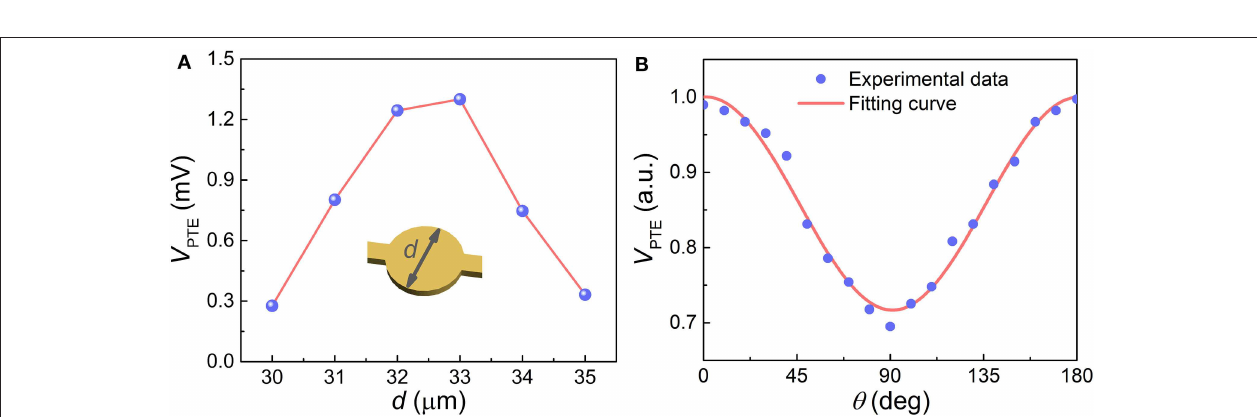
FIGURE 5 | (A) PTE response with different metal disc diameters. (B) Polarization dependence of the photovoltage (0 ◦ degree corresponds to the polarization parallel to the y -direction), and the red curve is a sine fit of the experimental data.